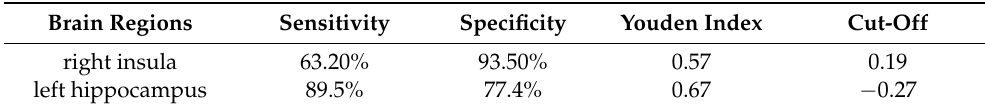
Table 3. Yordon index, cutoff values, sensitivity, and specificity for the right insula and the left